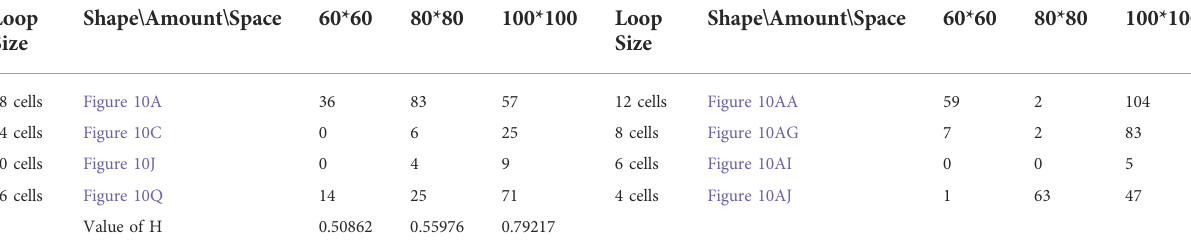
TABLE 8 Statistical numbers of the loops with various structures for the greedy selection mechanism on different cellular spaces starting from the initial con fi guration in Figure 7C. Loop